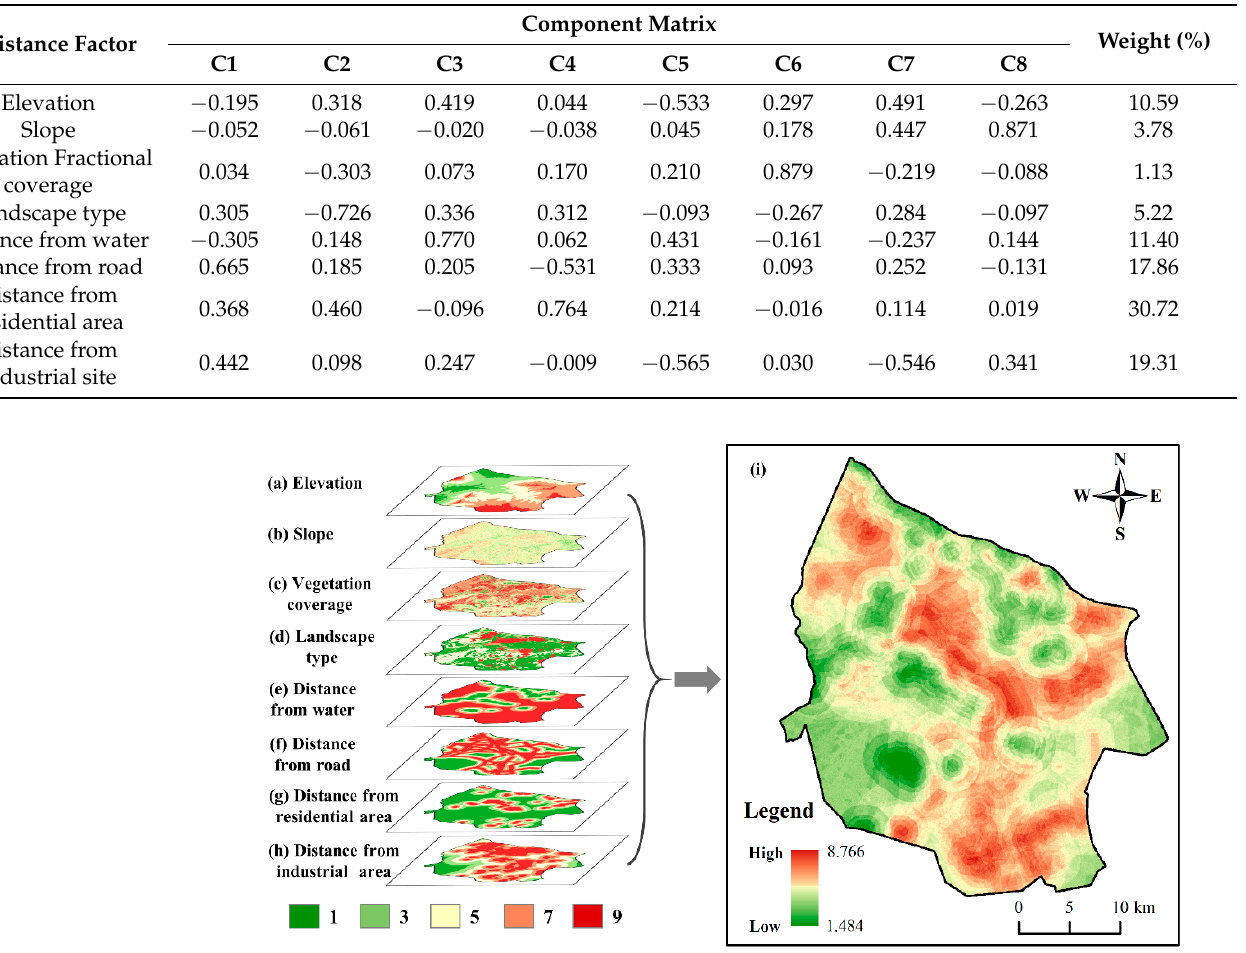
Figure 8. Landscape ecological resistance surface.